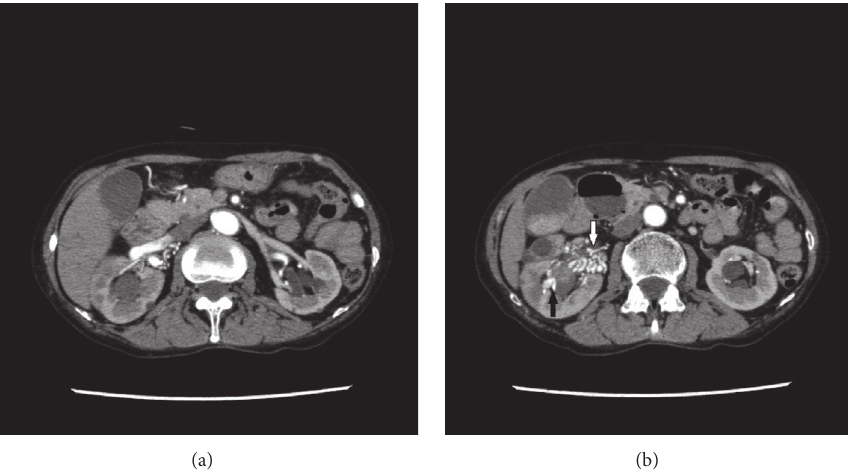
Figure 1: (a) The right renal vein was enhanced in the early phase. (b) There are multiple tortuous vessels around the right renal hilus (white arrow), part of which invaded into the renal parenchyma and renal calix (black